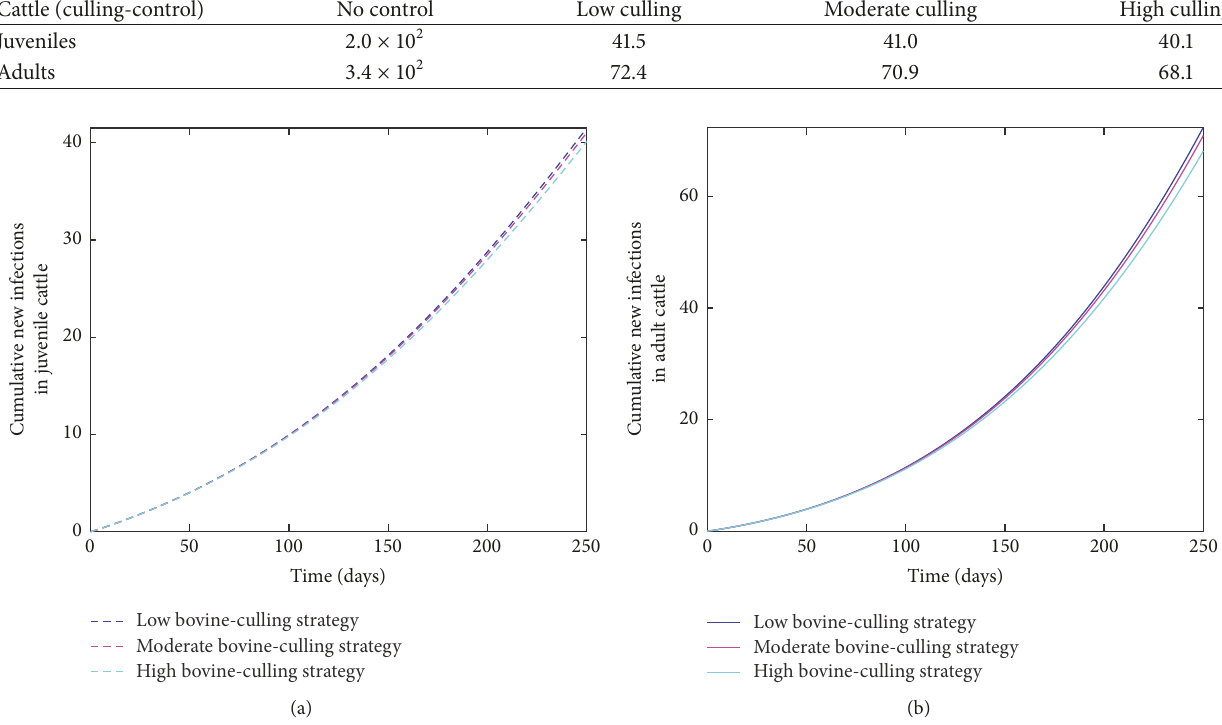
Table 4: Simulation results of the cumulative number of new cases at 𝑡 = 250 days for the juvenile and adult cattle using the bovine-culling strategy.